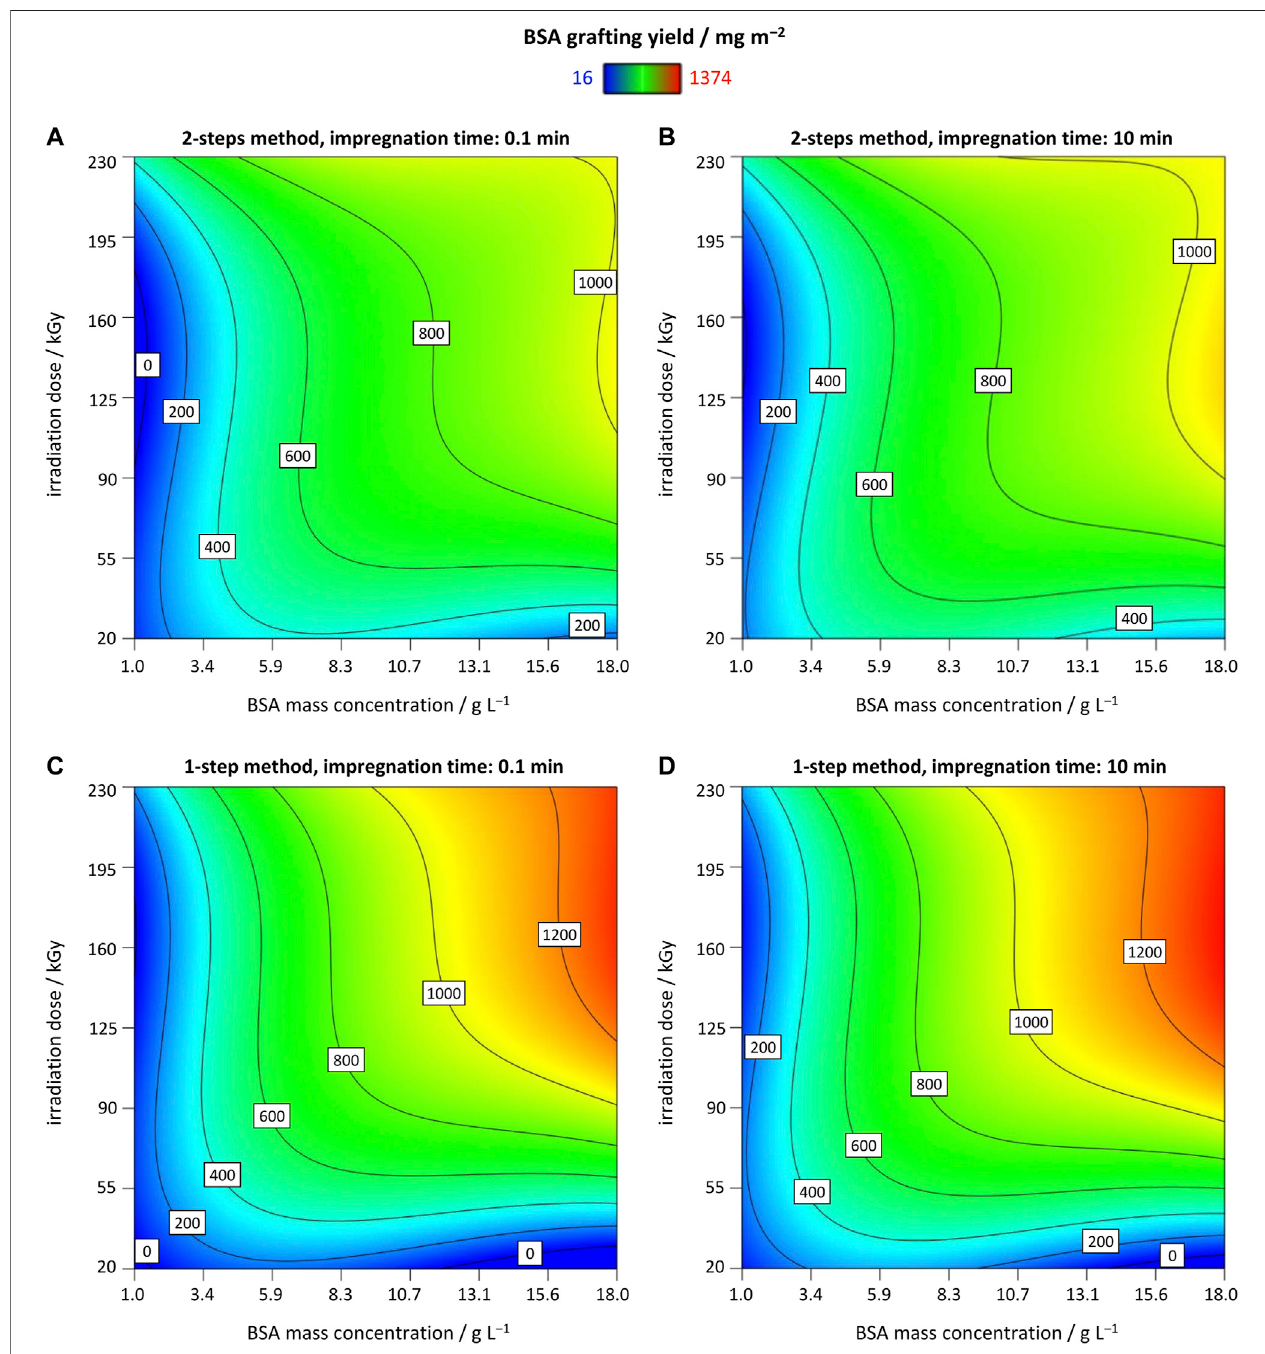
FIGURE3| ContourplotsofresponseR1,BSAGY,asafunctionofBSAmassconcentrationintheimpregnationsolution,irradiationdose,andimpregnationtime, t, for 2-steps method at (A) t (cid:1) 0.1 min; (B) t (cid:1) 10 min; and for 1-step method at (C) t (cid:1) 0.1 min; (D) t (cid:1) 10 min.